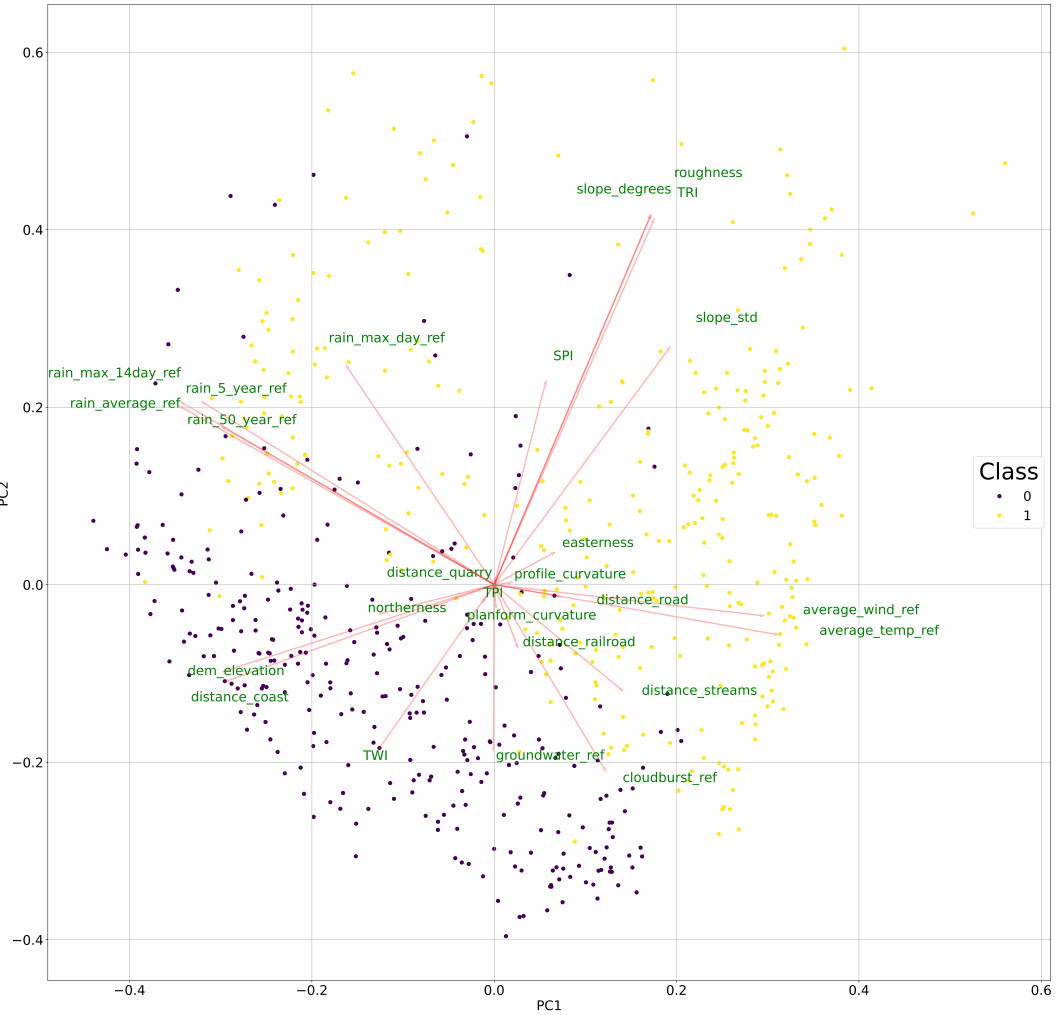
Figure 4. PCA biplot with principal component loadings of variables, where class 0 indicates non- landslide samples, while class 1 is